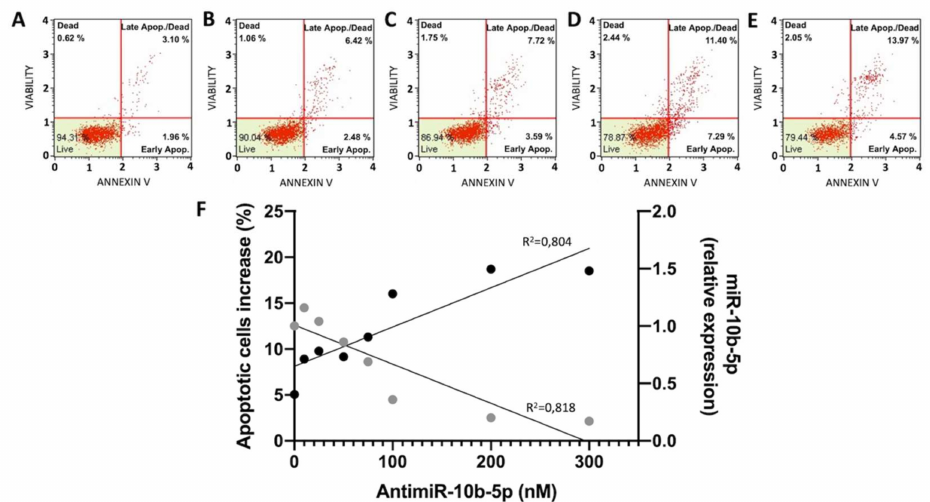
Figure 3. Effects of anti-miR-10b-5p on apoptosis. ( A – E ). Representative Annexin V assay plots performed on untreated U251 cells ( − )or cells cultured for 3 days in the presence of DMSO or the indicated concentrations of anti-miR-10b-5p (C. 50 nM, D. 200 nM, E. 300 nM). The complete set of data is presented in Supplementary Material Figures S3 and S4. ( F ). Summary representing the increase of % of apoptotic cells (black dots) related to the decrease of miR-10b-5p following treatment with the anti-miR-10b-5p molecule (grey dots), R squared values obtained by linear regression test are presented on the